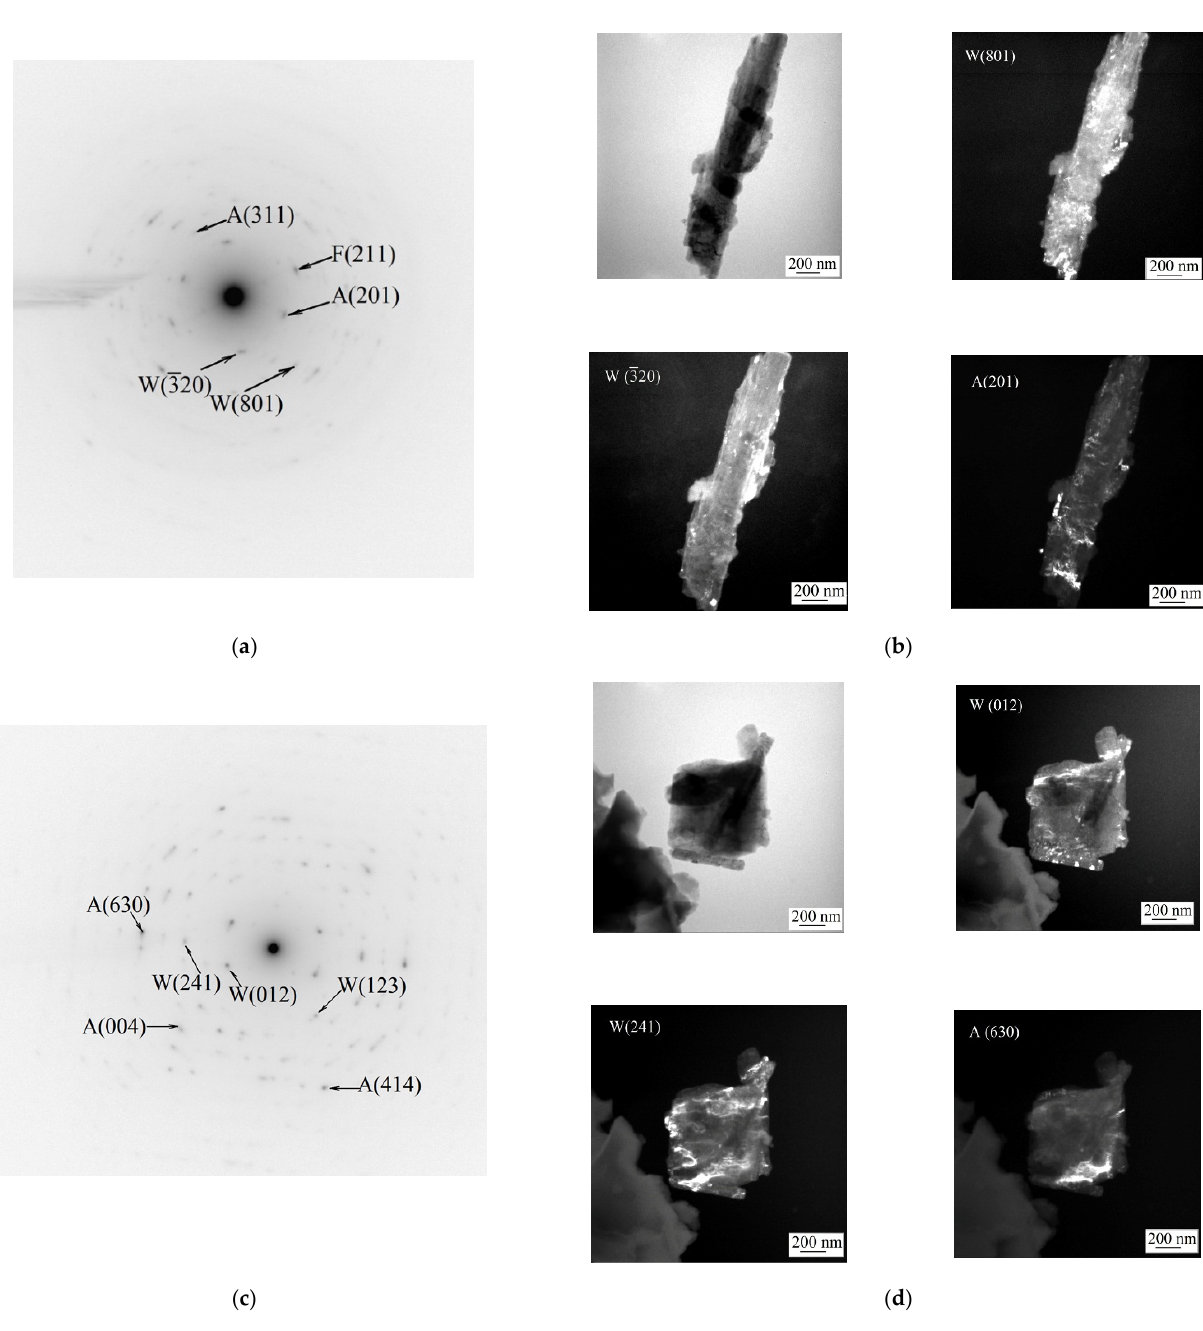
Figure 8. SAD pattern ( a , c ), light-field, and dark-field ( b , d ) TEM images of the fragments of W-coatings deposited at the voltages of 350 V ( a , b ) and 500 V ( c , d ).